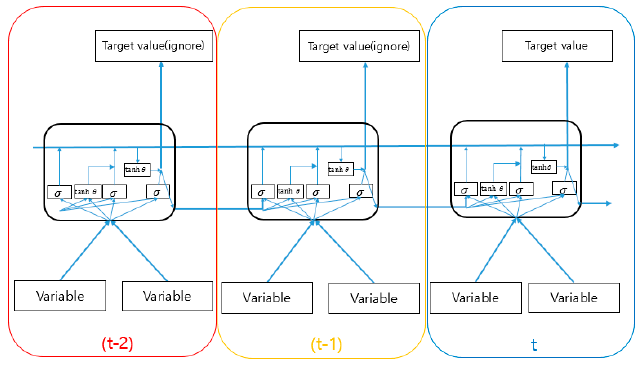
Figure 17. Basic structure of LSTM.